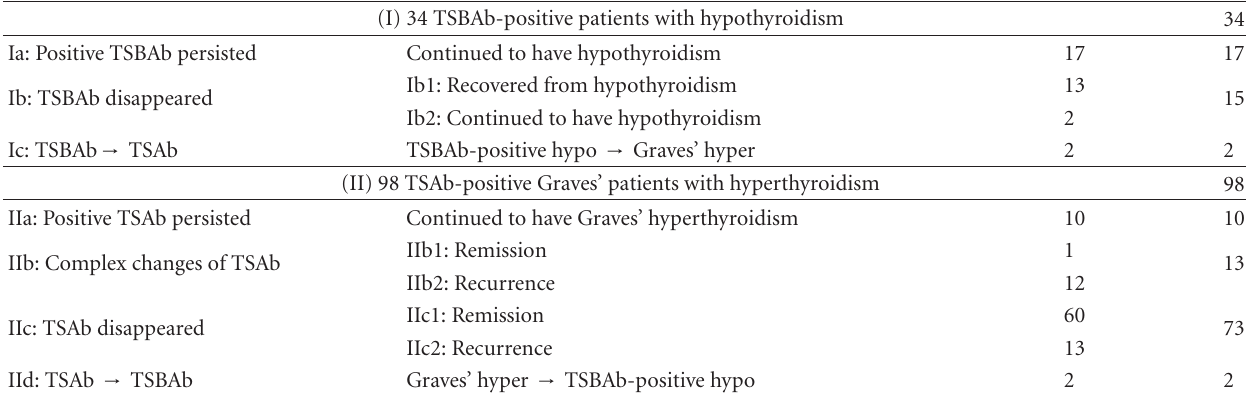
Table 1: Changes of TSBAb (TSH-stimulation blocking antibody) and TSAb (thyroid stimulating antibody) over 10 years in 34 TSBAb- positive patients with hypothyroidism and in 98 TSAb-positive Graves’ patients with hyperthyroidism. (I) 34 TSBAb-positive patients with